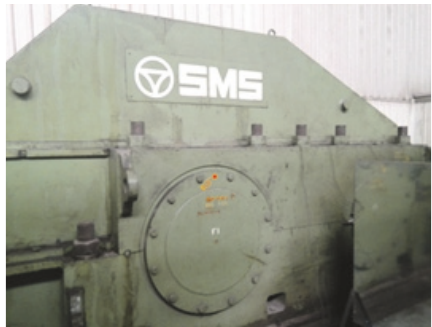
Figure 6: The gearbox of rolling